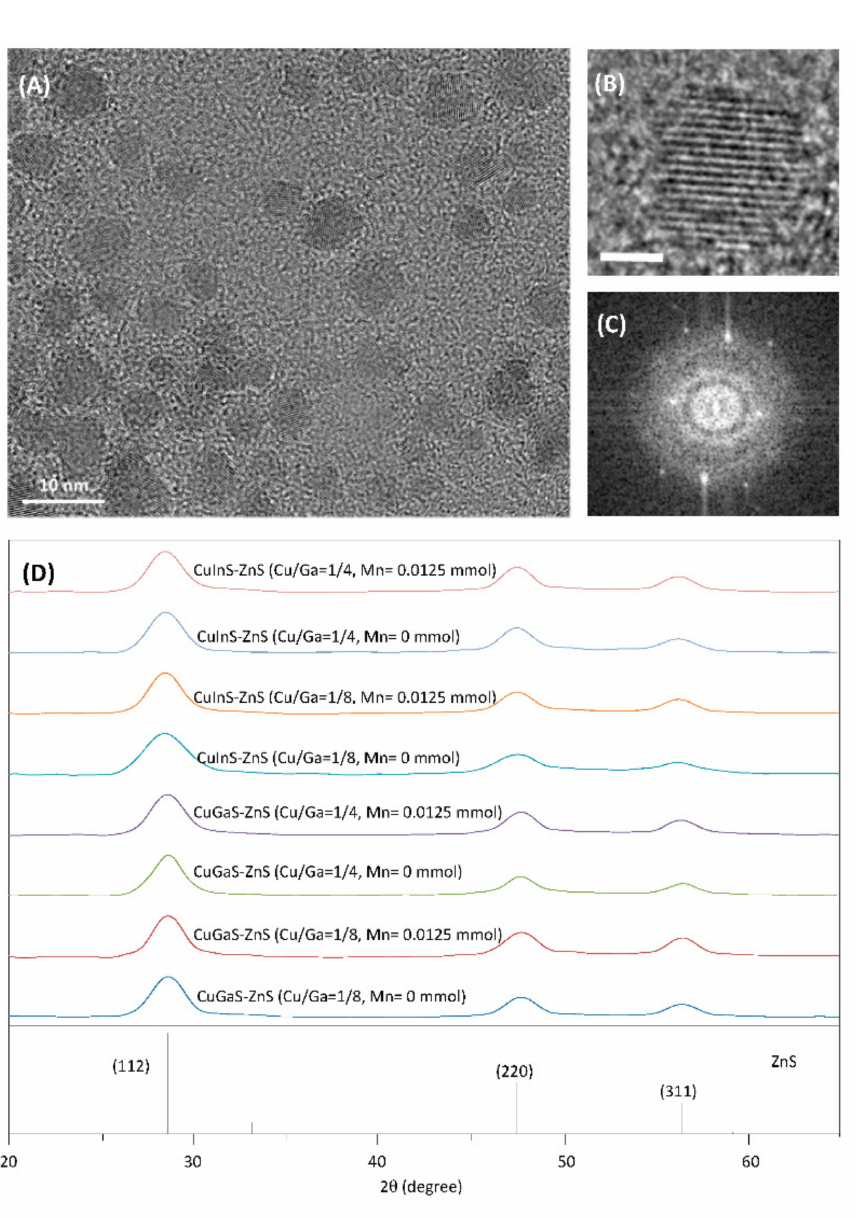
Figure 2. ( A , B ) TEM and high-resolution TEM (HRTEM) images of Mn:CuGaS-ZnS (Cu/Ga = 1/8, Mn = 0.0125 mmol) NCs. The scale bar in HRTEM image is 2 nm. ( C ) Fast-Fourier-Transform (FFT) pattern on the HRTEM image of the Mn:CuGaS-ZnS NCs. ( D ) XRD patterns of different types of host NCs and Mn-doped NCs (Mn = 0.0125 mmol for each type of host